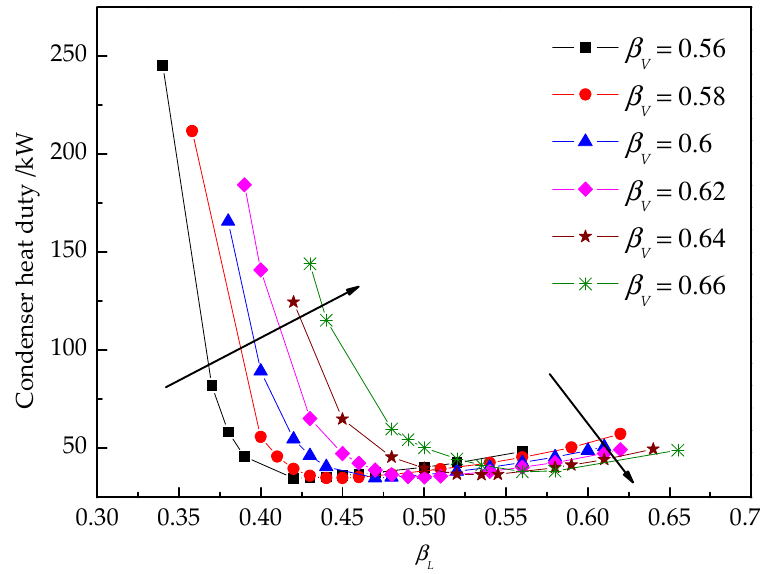
Figure 9. The effect of liquid split ratio on the condenser heat duty for the case